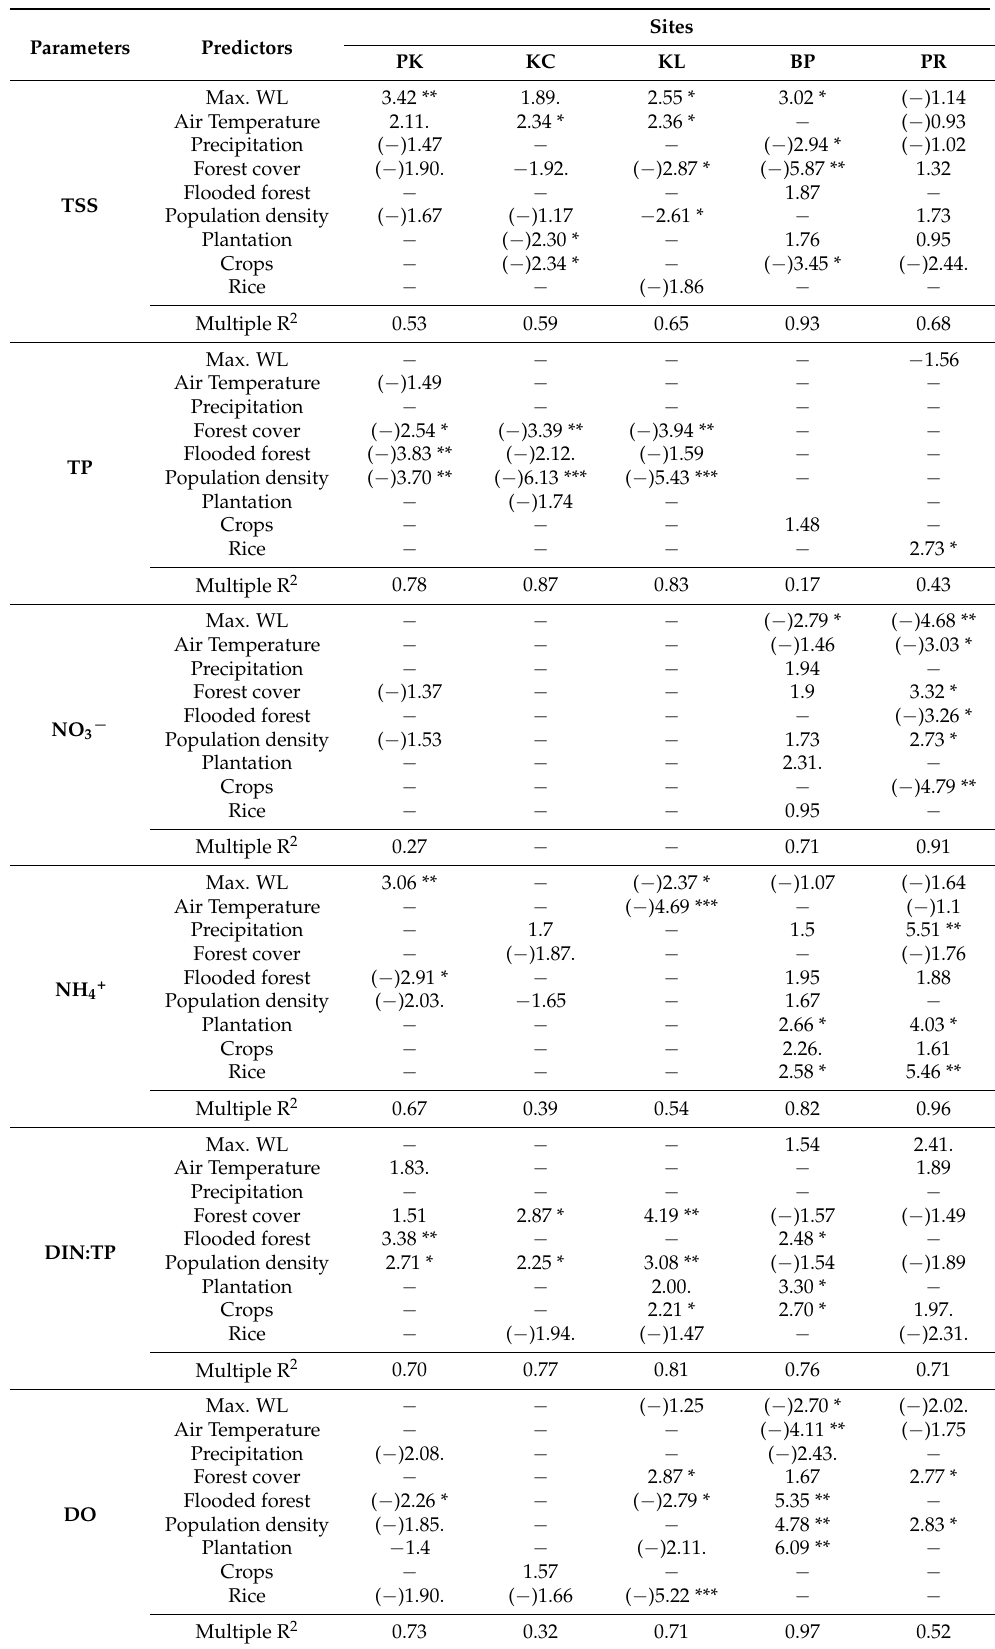
Table 3. Multiple linear regression coefficients between the eight water quality parameters and independent variables by site in the Tonle Sap